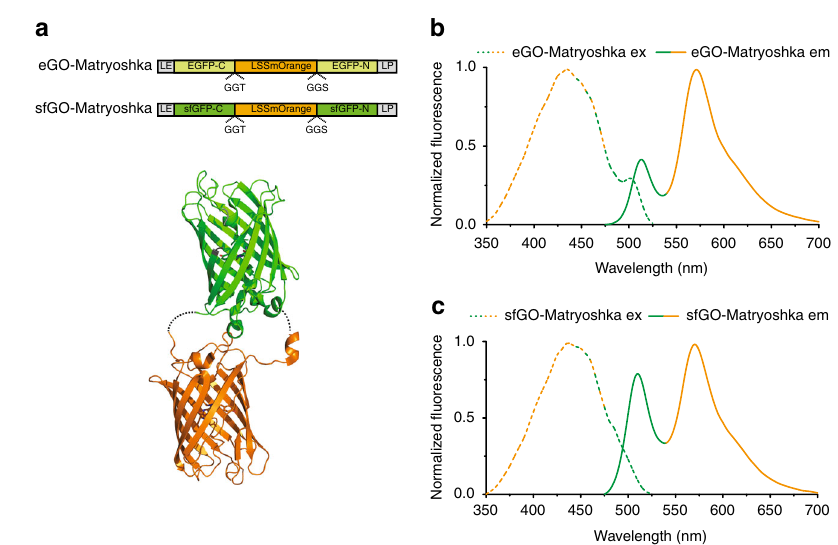
Fig. 1 GO-Matryoshka design. a Schematic representation of eGO-Matryoshka and sfGO-Matryoshka: LSSmOrange (reference domain) is sandwiched between the C and N termini of EGFP ( light green ) and sfGFP ( dark green ). LE and LP ( dark gray ) represent the fl anking residues. b , c Normalized steady- state fl uorescence excitation ( λ em 570 nm; dashed line ) and emission ( λ exc 440 nm; solid line ) of eGO-Matryoshka ( b ) and sfGO-Matryoshka ( c ) at pH 10.5 (FI is maximal at this pH; independent spectral analysis of four biological replicates). Note that the intensities in the green emission channel are affected by the terminal residues, as they affect the cpFP FI, chromophore quantum yield and p K a . The combination LS/FN yielded a more acidic p K a than the LE/LP combination (Supplementary Fig.